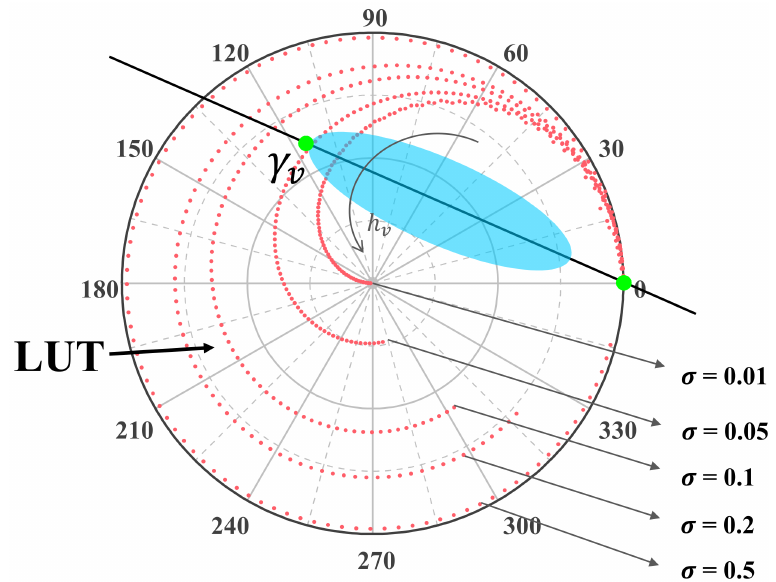
Figure 6. Schematic diagram of the three-stage inversion method. The black straight line is the fitted coherence line, the blue shaded area is the coherence region composed of different polarized coherence points, the green points indicate volume-only scattering and ground coherence points, and the red points indicate the 2D lookup table calculated by the RVoG model, in which the average extinction coefficient values of the points in each curve are the same, but gradually moves away from the phase origin as the forest height increases. The different curves represent different average extinction coefficients, and the closer they are to the circumference, the larger the value of extinction coefficient. Moreover, θ 0 in the figure is 45 ◦ , h v ranges from 0 to 50 m, and the interval between two adjacent points is 0.5